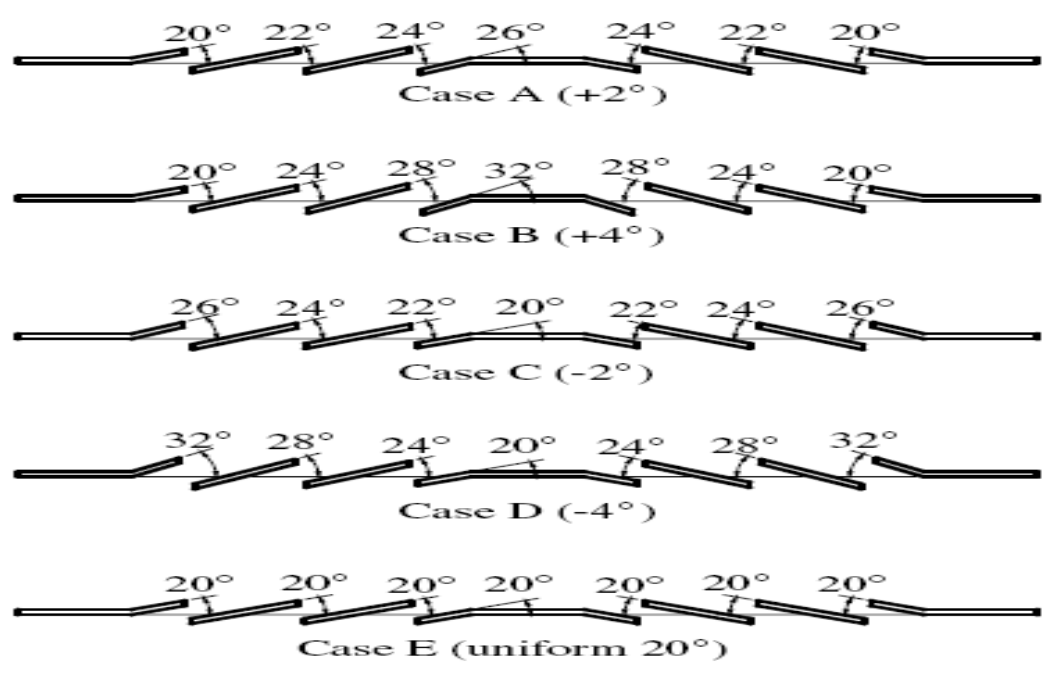
Figure 13: Different case models of heat exchanger